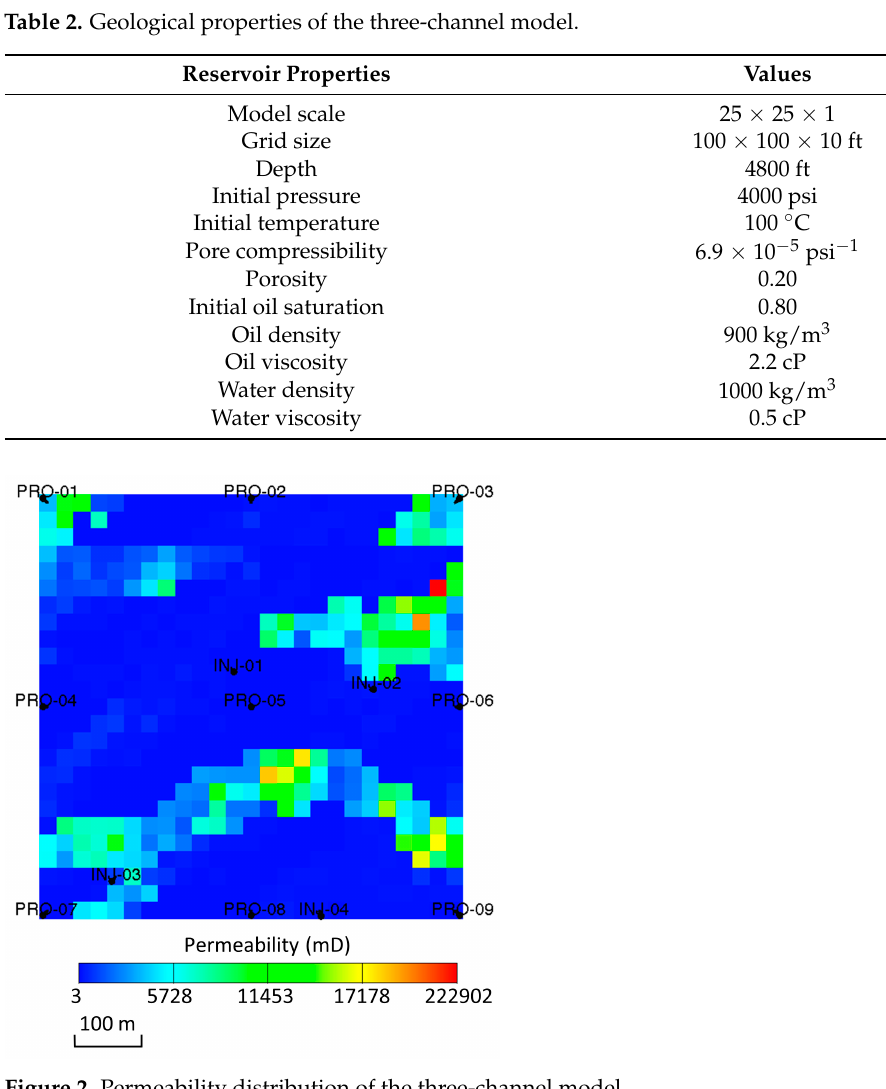
Figure 2. Permeability distribution of the three-channel model. Table 2. Geological properties of the three-channel